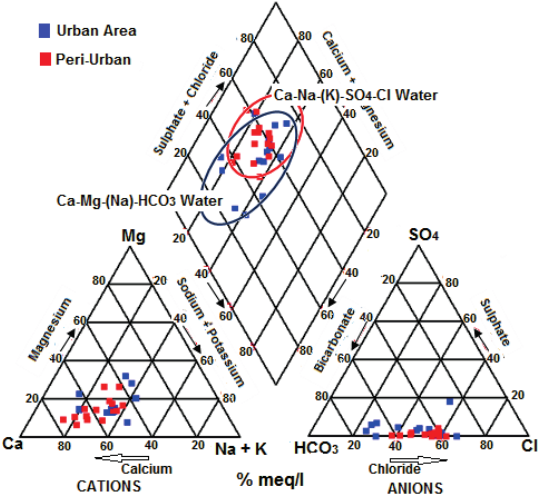
Fig. 3 Piper plots of water samples from the study area.